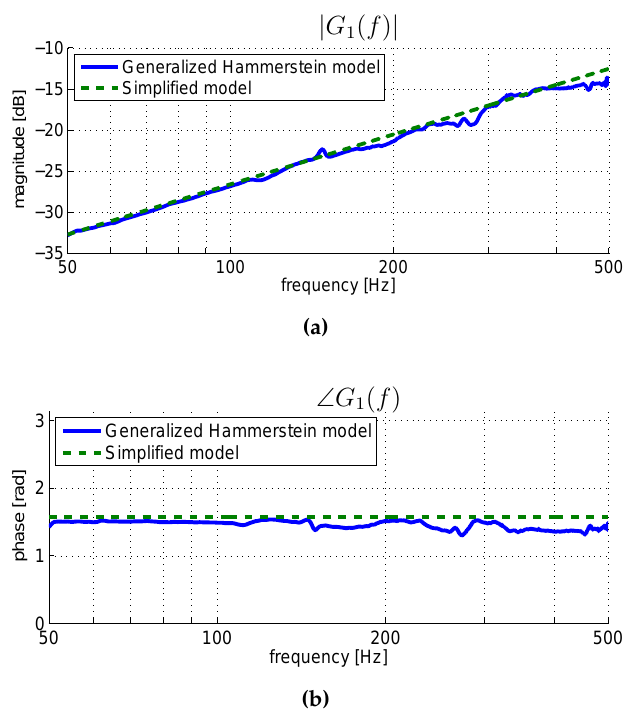
Figure 6. Modulus ( a ) and phase ( b ) of the first filter G 1 ( f ) of the identified Generalized Hammerstein model of the pickup under test (blue solid line) and the equivalent frequency response of the simplified Hammerstein model followed by a differentiator (green dashed